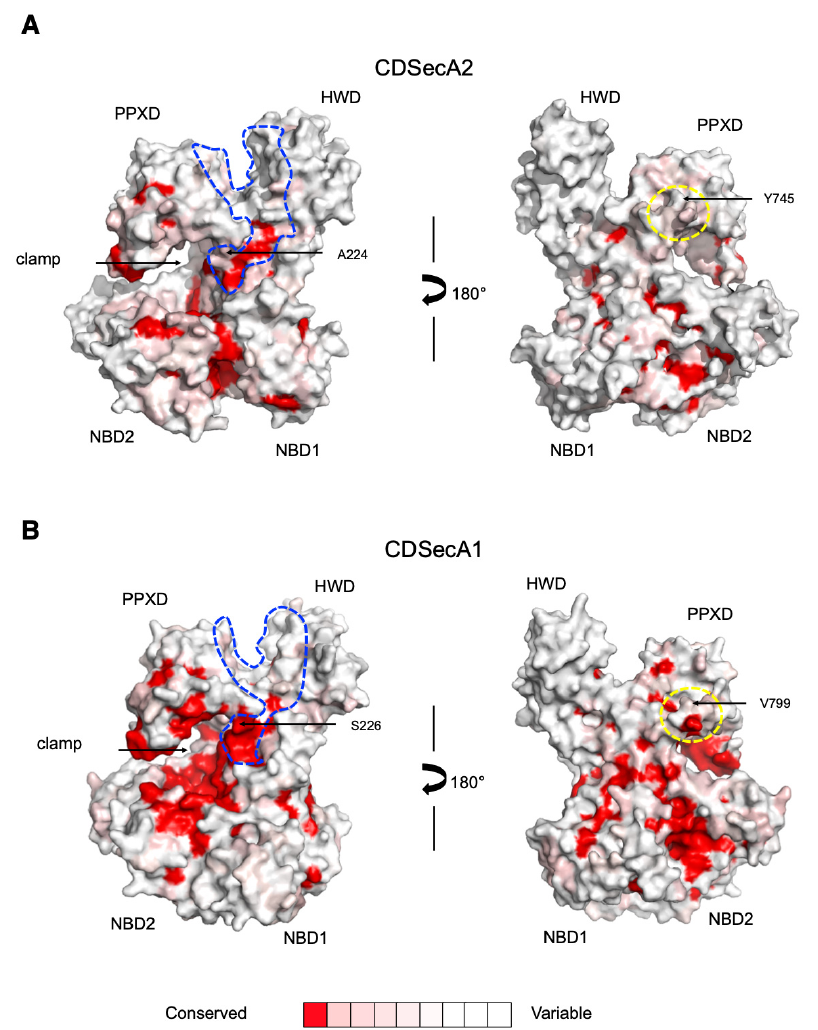
Figure 5. Surface conservation of SecA proteins in SecA2-encoding organisms. ( A ) Conservation of the SecA2 surface is shown based on the SecA2 structure of C. di ffi cile and 30 of its orthologues. ( B ) Conservation of the SecA1 surface is shown based on the CDSecA1 model and 30 of its orthologues. Both models are shown in an open conformation and were built using B. subtilis SecA (PDB ID 3JV2) as a template. The clamp enclosing the protein target is depicted with an arrow, the signal-peptide binding groove is encircled with a blue line, and the 2HF loop is indicated with a yellow circle. Residues with the highest conservational scores are shown in red, and the color coding is shown at the bottom of the